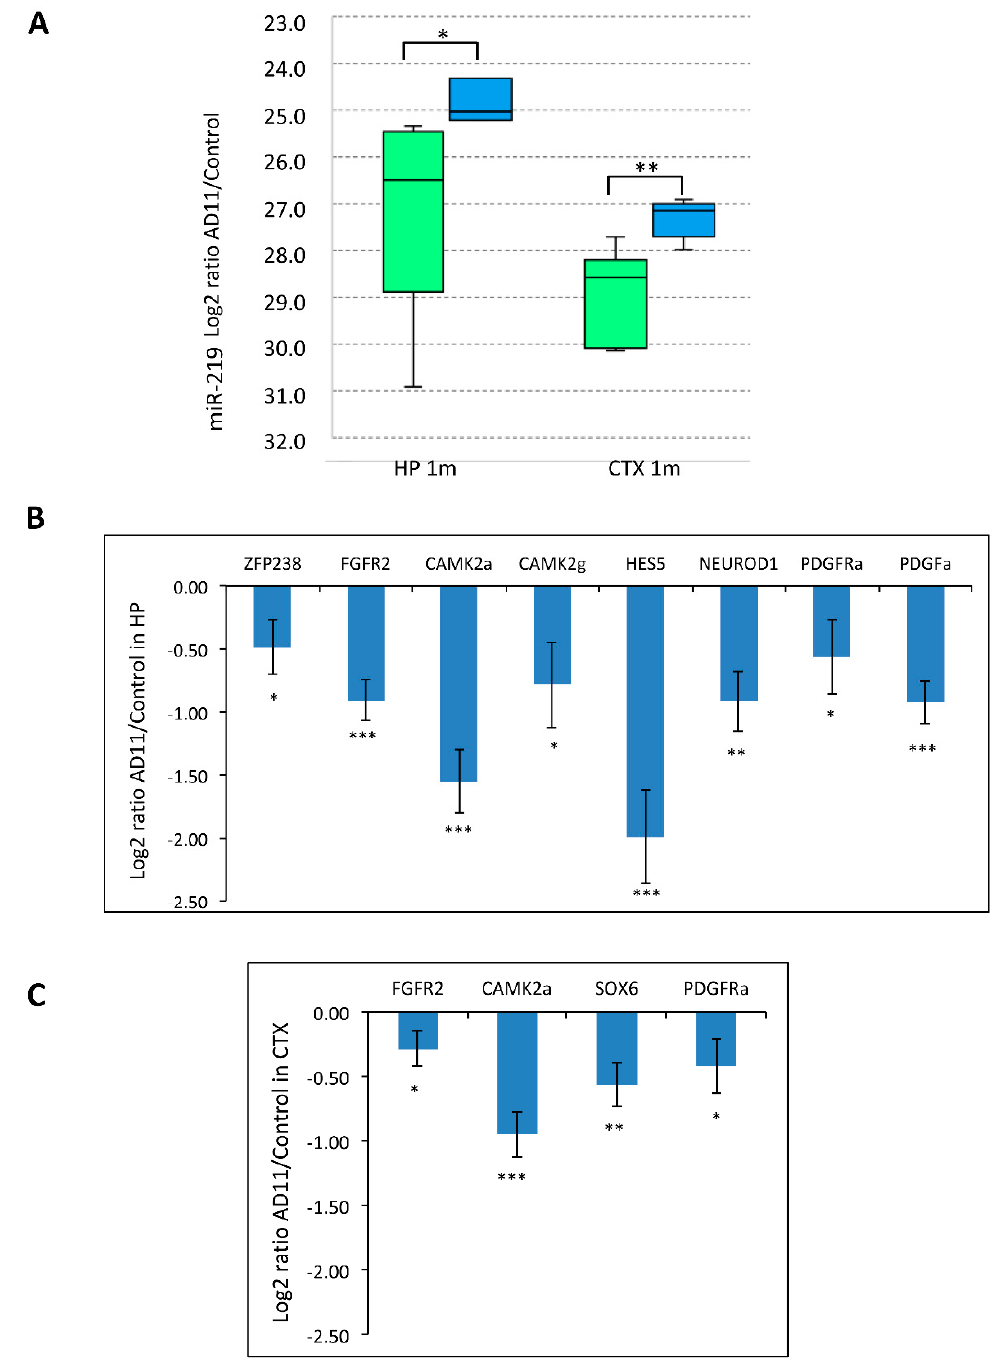
Figure 3. Validated miR-219 target mRNAs are downregulated in AD11 brains. ( A ): Up-regulation of miR-219 in the cortex (CTX) and hippocampus (HP) of AD11 mice at 1 month of age, by qRT-PCR. The normalized Ct of AD11 mice (blue) and VH mice (green) are shown. Statistical significance by one-tail heteroscedastic Student’s t -test: * p < 0.05, ** p < 0.01. The Ct axis is in reverse order to highlight the up-regulation of miR-219. The results are expressed as the mean ± standard error (SEM) from independent experiments ( n = 3–7). ( B , C ): Log2 ratio of differentially expressed miR-219 target mRNAs in AD11 hippocampus ( B ) and cortex ( C ) at one month of age by qRT-PCR (AD11/VH control). The results are expressed as the mean ± standard error (SEM) from independent experiments ( n =7). Statistical significance is calculated relative to the control samples. Student’s t -test: * p < 0.05, ** p < 0.01, *** p < 0.001.